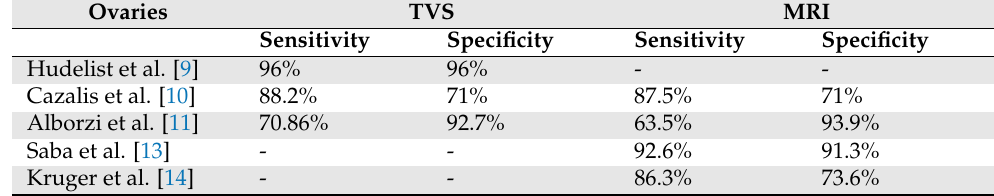
Table 2. The diagnostic accuracy of TVS and MRI in ovarian endometriosis (as reported in different studies). Ovaries TVS MRI Sensitivity